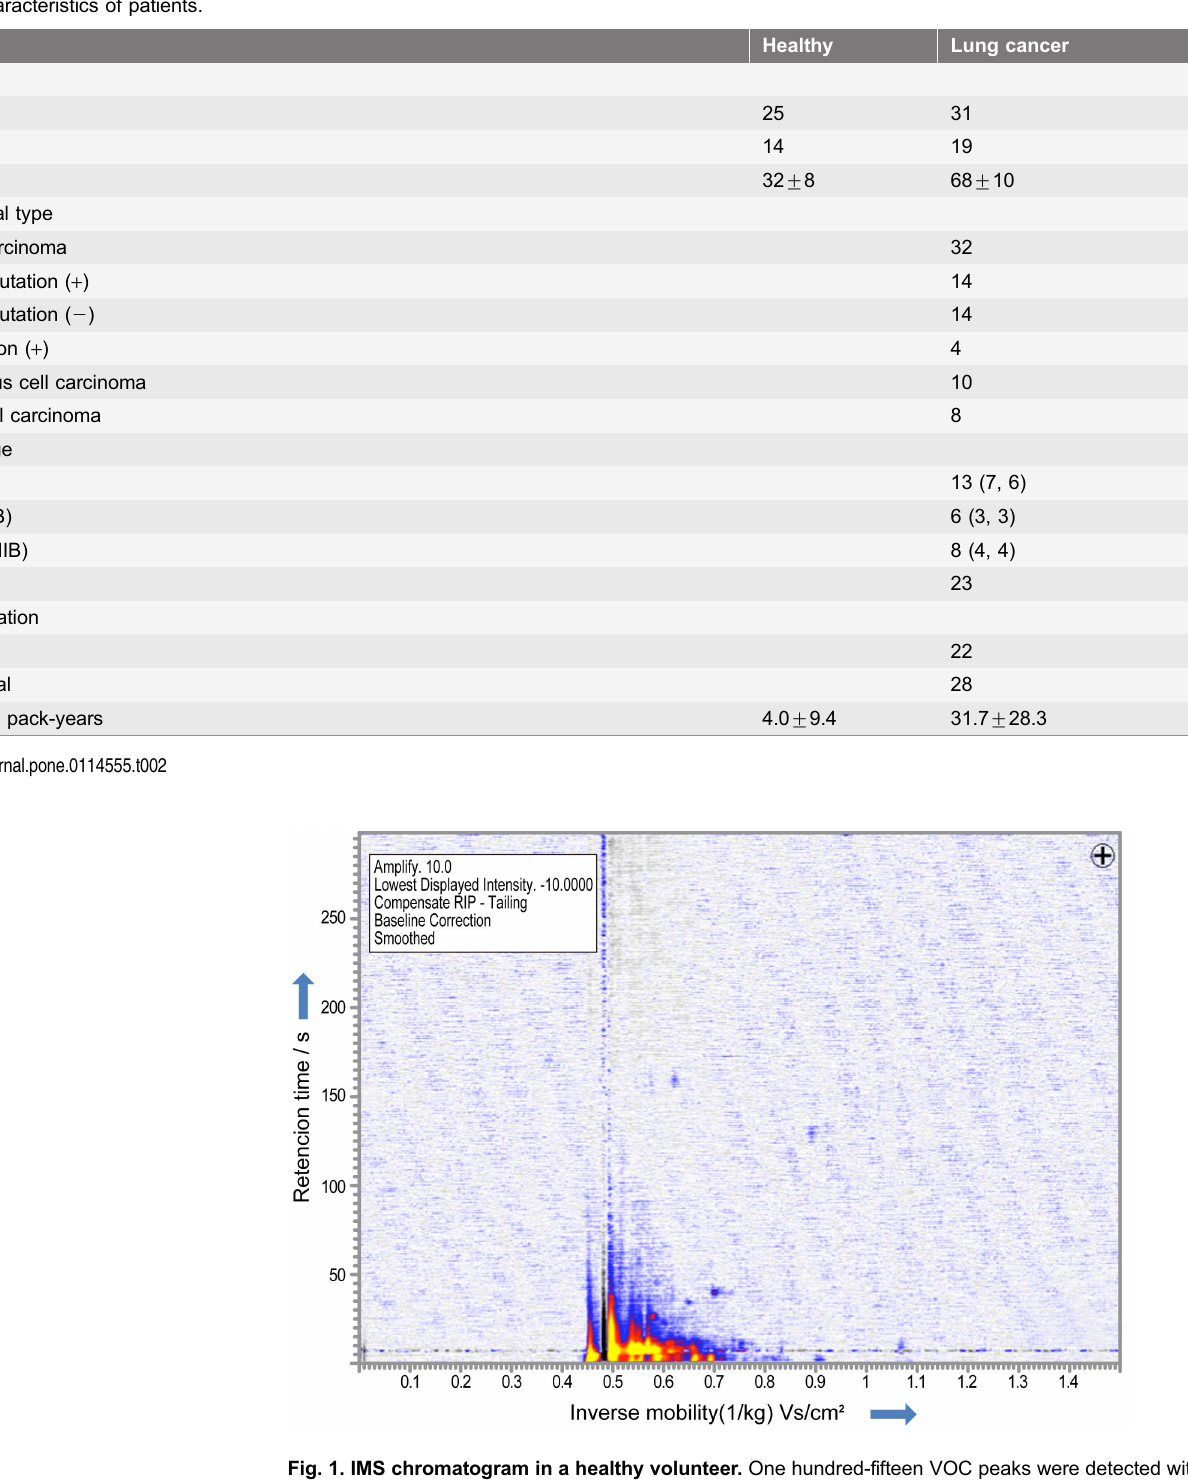
Fig. 1. IMS chromatogram in a healthy volunteer. One hundred-fifteen VOC peaks were detected with ion mobility spectrometry in patients with lung cancer and healthy